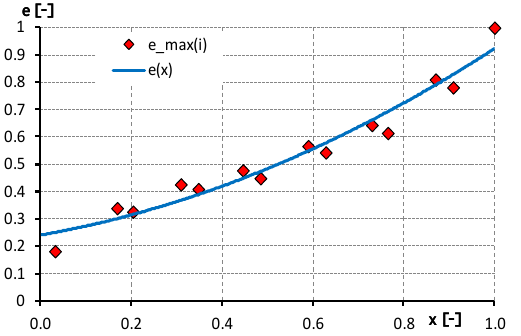
Figure 8. Local maxima of the non-dimensional gas kinetic energy e max (i) in the staggered seal with the approximating line e ( x ) for boundary conditions 𝑝 𝑖𝑛 /𝑝 𝑜𝑢𝑡 = 2, 𝑇 𝑖𝑛 = 300 K , 𝑝 𝑜𝑢𝑡 = 10 5 Pa .